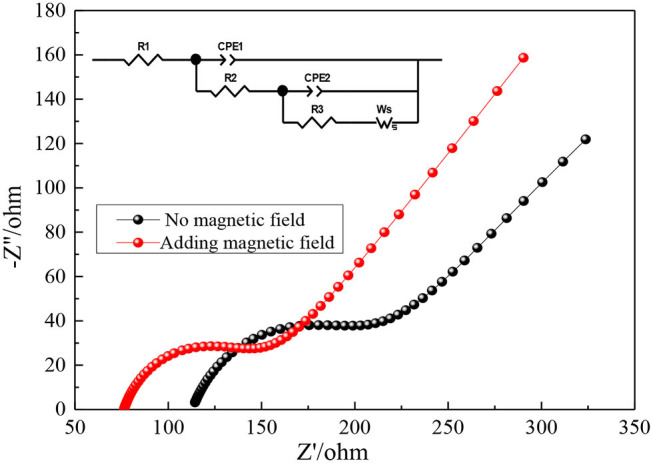
Nyquist plot of 0.1 M VCl3 electrolyte with or without magnetic field.